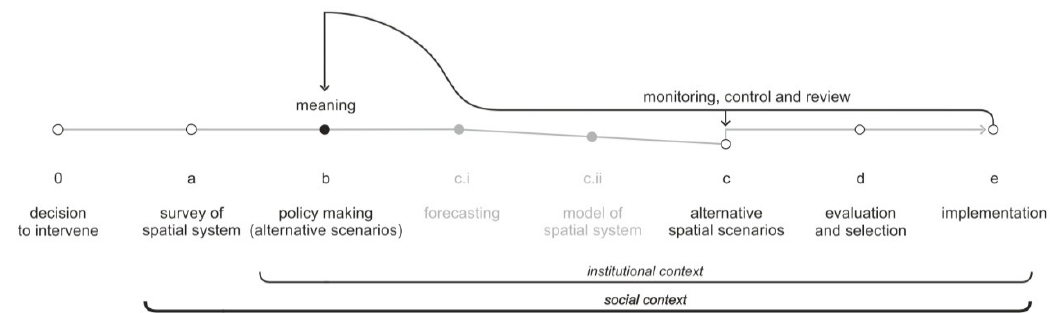
Figure 9. The sub-processes of collaborative spatial planning, according to Healey [22,23], in diagrammatic form, with the comprehensive model’s components in the background. White circle: coincidence with McLoughlin’s component. Gray circle: lack of the corresponding McLoughlin component. Dark circle: the central component, also included in McLoughlin’s components. Below the axis: contextual factors.